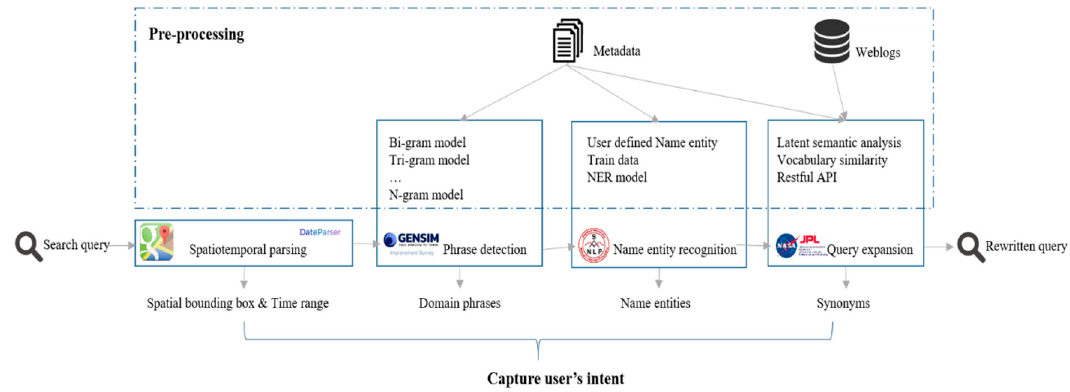
Figure 7. Workflow of query